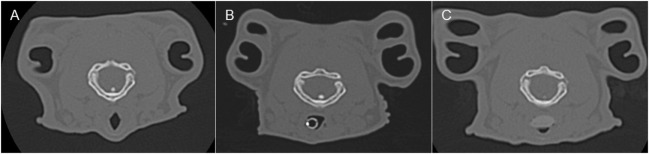
Representative transverse CT images of the rabbits depicted in Figure 2, where (A) is before airway device placement, (B) is with the endotracheal tube inserted, and (C) is with the supraglottic airway device (SGAD) in situ. The image in (C) shows the narrowest cross-sectional area of the airway, including the SGAD tip. Panels (A,B) represent the same anatomical level as (C).